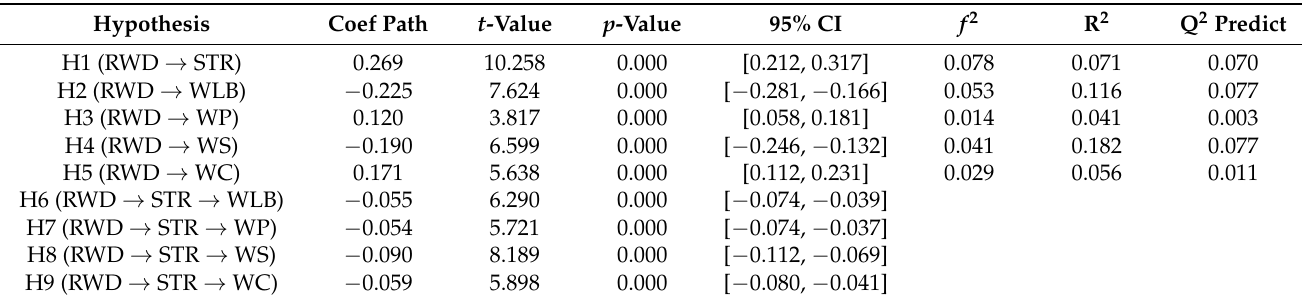
Table 3. Structural Model